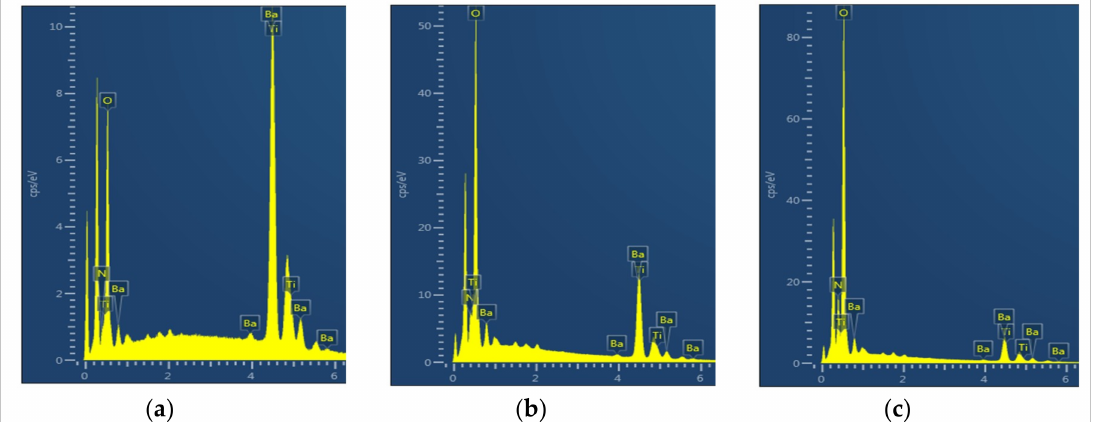
Figure 13. EDX-spectra of: ( a ) Nitrogen-free and oxygen-depleted: [N] = 0.0; [O] = 0.333; [Ba] = 0.343; [Ti] = 0.324. ( b ) Nitrogen-depleted region: [N] = 0.028; [O] = 0.674; [Ba] = 0.157; [Ti] = 0.142; ( c ) Nitrogen and oxygen rich region: [N] = 0.219; [O] = 0.680; [Ba] = 0.094; [Ti] =